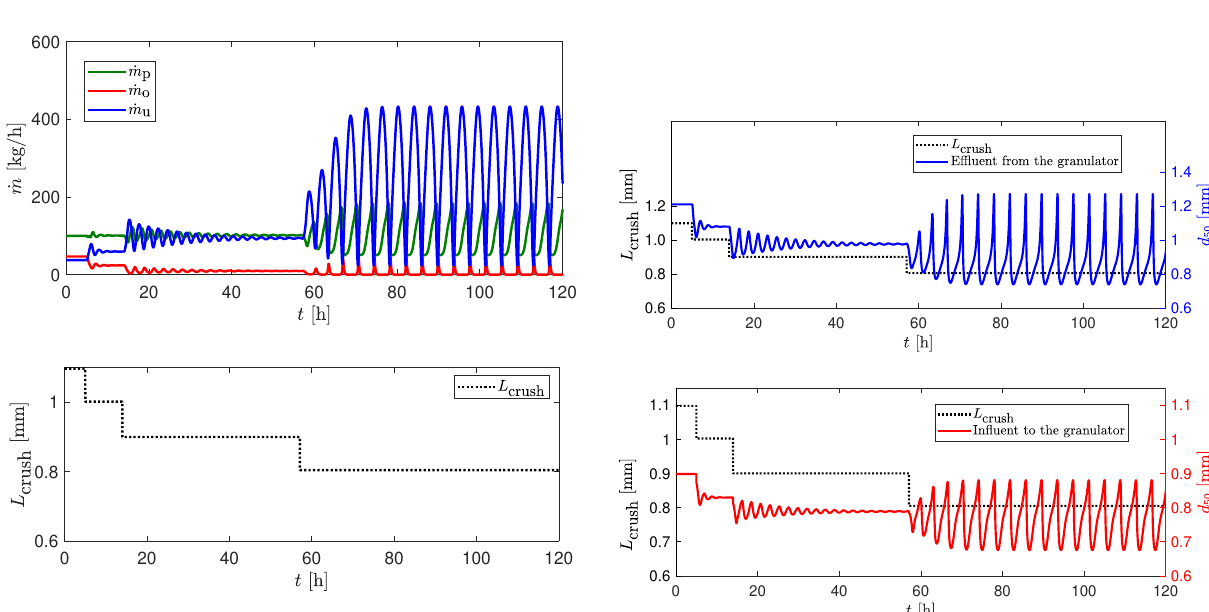
Figure 9: Mass flow rates of over-sized, product-sized and under-sized particles as a response to the step-by-step change of the crusher gap ( L crush = 1 . 1 → 1 . 0 → 0 . 9 → 0 . 8 mm).